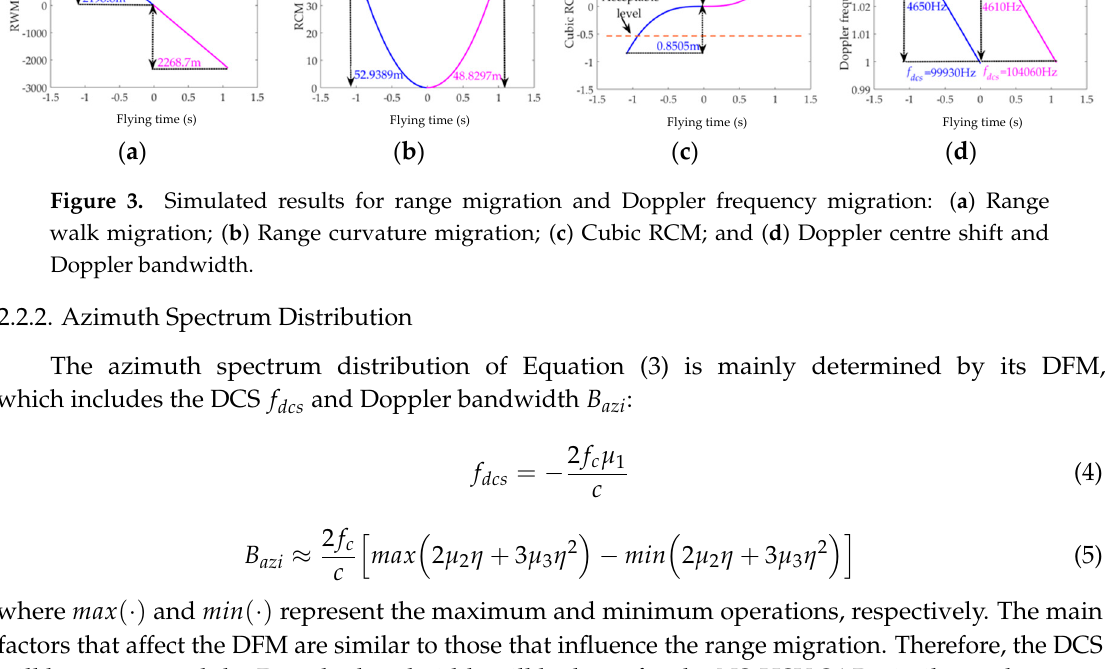
Figure 7. Simulated results for pre ‐ processing: ( a ) remaining range migration; and ( b ) remaining DFM.